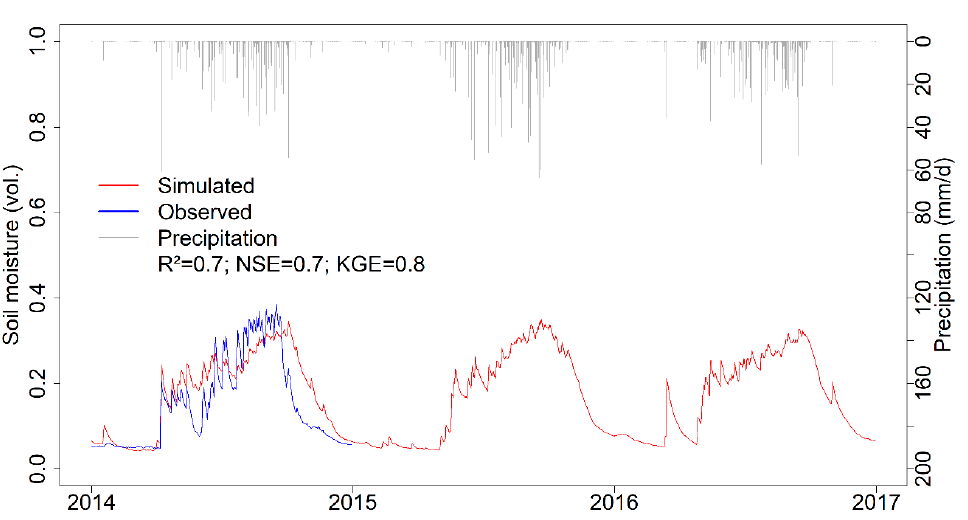
Figure 9. Comparison of daily average simulated top soil water and observed soil moisture at Bankandi-south (measured soil moisture data at 10 cm depth were only available for 2014 at the soil moisture station).